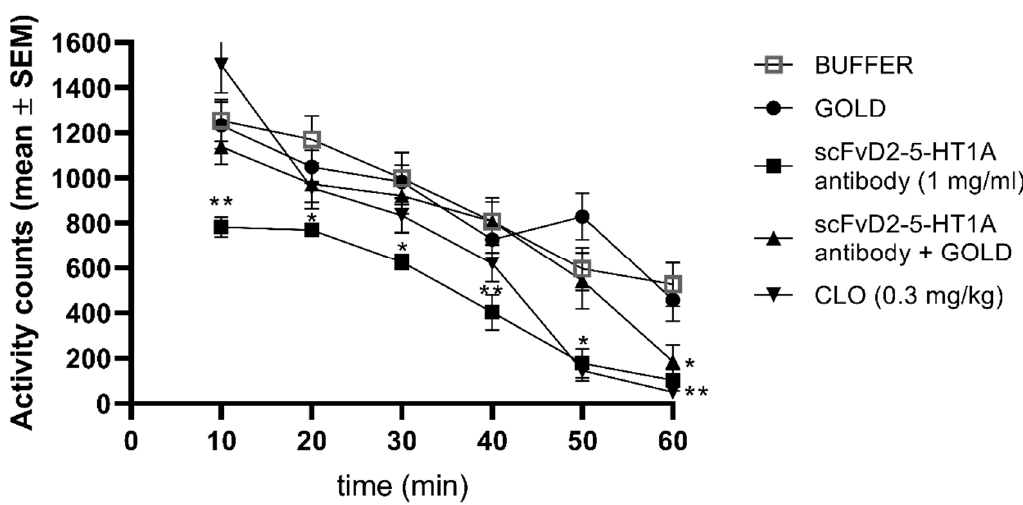
Figure 10. The locomotor activity of mice following i.p. administration of 100 µ L of phosphate buffer (BUFFER), gold nanoparticles (GOLD), scFvD 2 –5-HT1A antibody (1 mg/mL); gold nanoparticles with the scFvD 2 –5-HT1A antibody and clozapine (0.3 mg/kg, CLO). Data are presented as mean ± SEM of activity counts over 60 min test in 10 min intervals and were analyzed using one-way ANOVA. The significant changes vs. control group (BUFFER) marked on the graph: ** p ≤ 0.01; * p ≤ 0.05; n = 8–14.